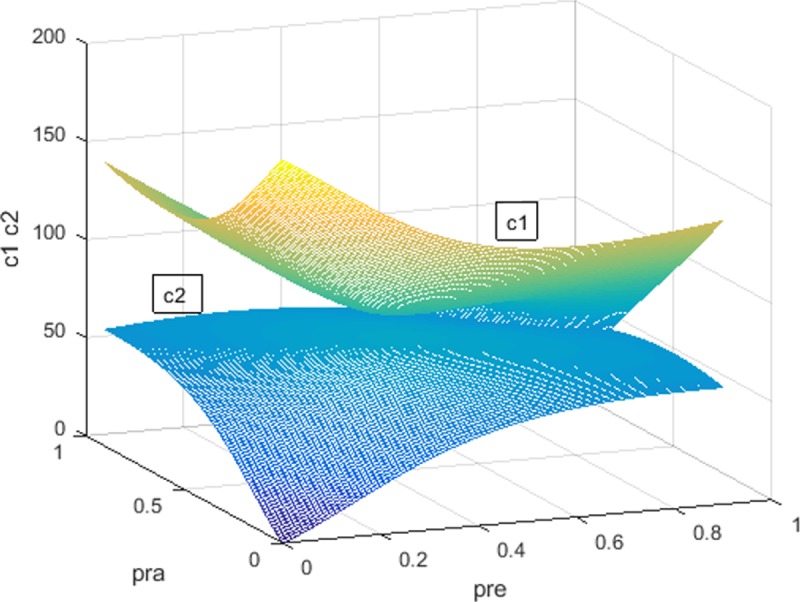
Comparison of c1, c2 in America.